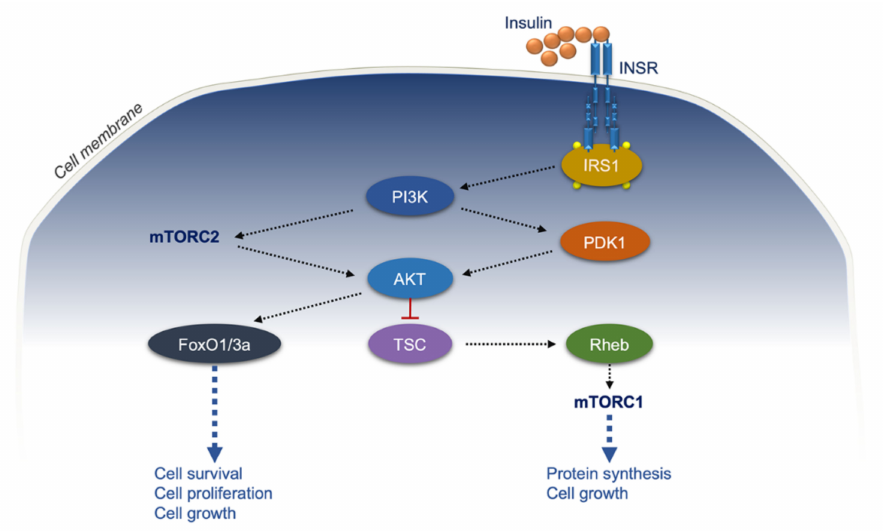
Figure 1. Insulin receptor signaling and cancer: scheme. INSR, insulin receptor; IRS1, INSR sub- strate 1; PI3K, phosphoinositide 3-kinase; PDK1, phosphoinositide-dependent protein kinase-1; AKT, Ak strain transforming/protein kinase B; FoxO1/3a, forkhead box protein O1/3a; TSC, tuber- ous sclerosis complex; Rheb, Ras homolog enriched in brain; mTORC1/2, mammalian target of rapamycin complexes; black dotted arrows, activation; blue dotted arrows, biological effects of the downstream